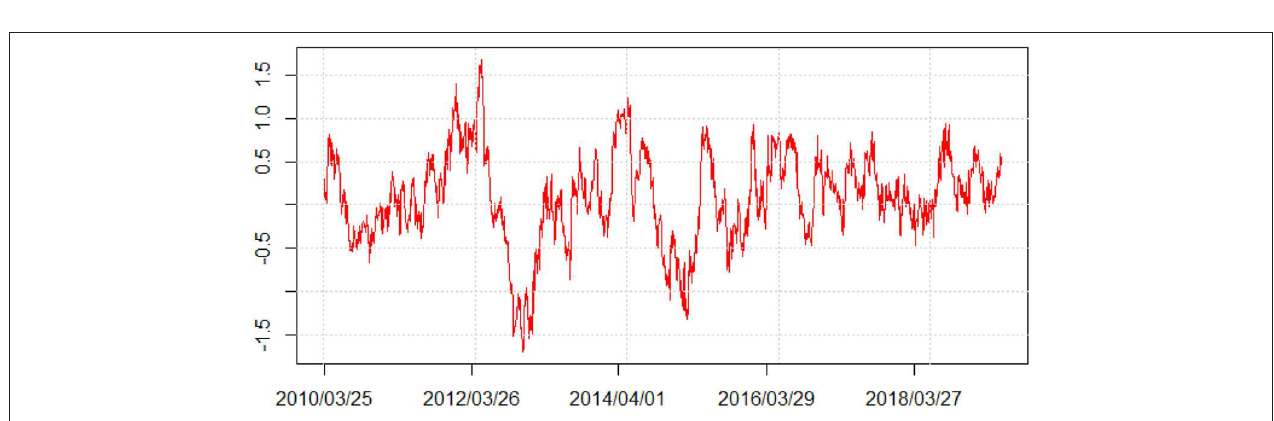
FIGURE 5 | Volatility spillovers from West Texas intermediate (WTI) to China’s bulk commodity sectors. (A) The total volatility spillovers from WTI to China’s bulk commodity sectors measured by Diebold and Yilmaz (2012), lag 2, window size 200. (B) The frequency decomposition measured by Baruník and Krehlík (2018), = = lag 2, window size 200. Short-term: frequencies from 1 to 5 days period (0-week, dark turquoise). Medium-term: frequencies from 5 to 20 days period = = (week-month, deep pink). Long-term: frequencies from 20 days to 200 days period (month-year, rosy brown).